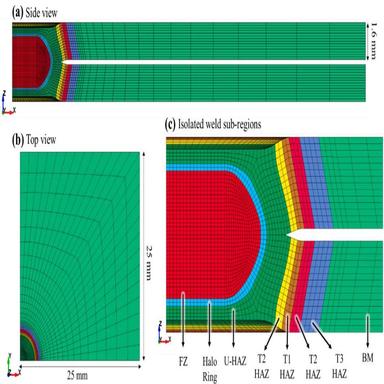
Detailed weld geometry for Usibor® 1500-AS-with-halo and isolated sub-region within the weld (Cross-tension test coupon).